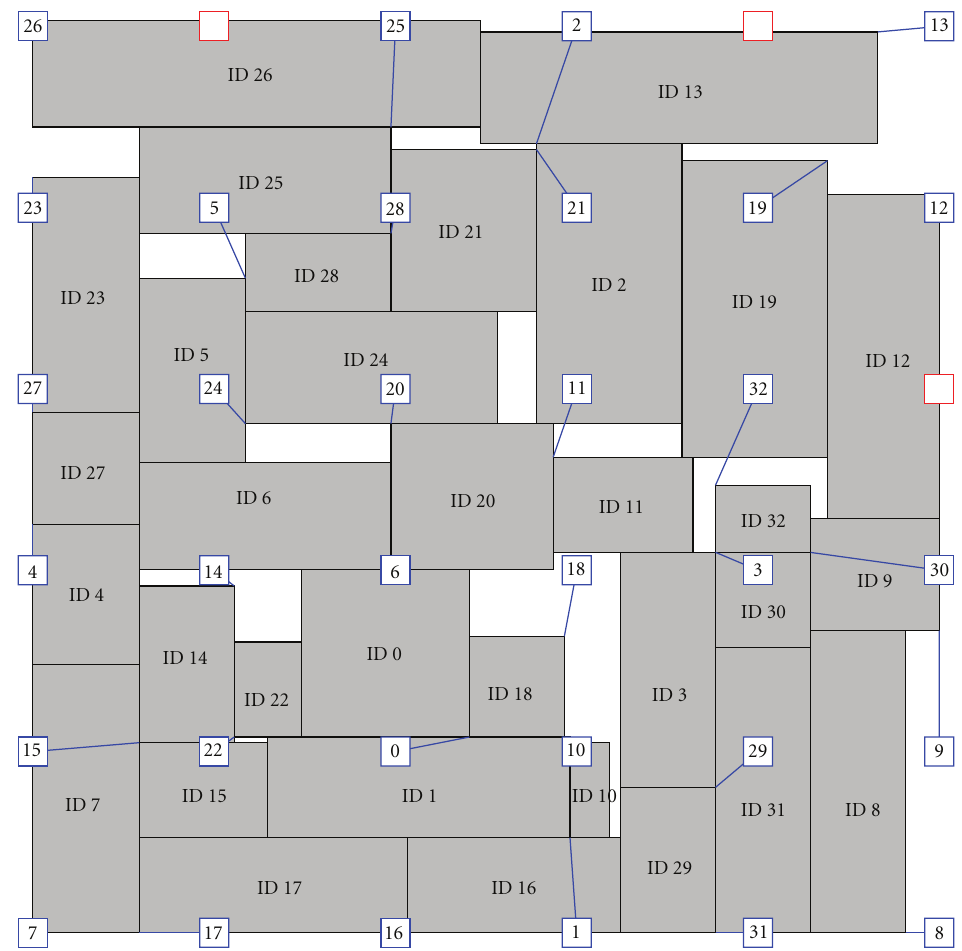
Figure 5: Screen capture with the result of floorplanning and routers assignment for ami33 . The NoC is a direct topology of 6 × 6, which is the minimum to guarantee at least a router for each IP/core. The extralinks are shown as straight lines between cores and assigned routers.